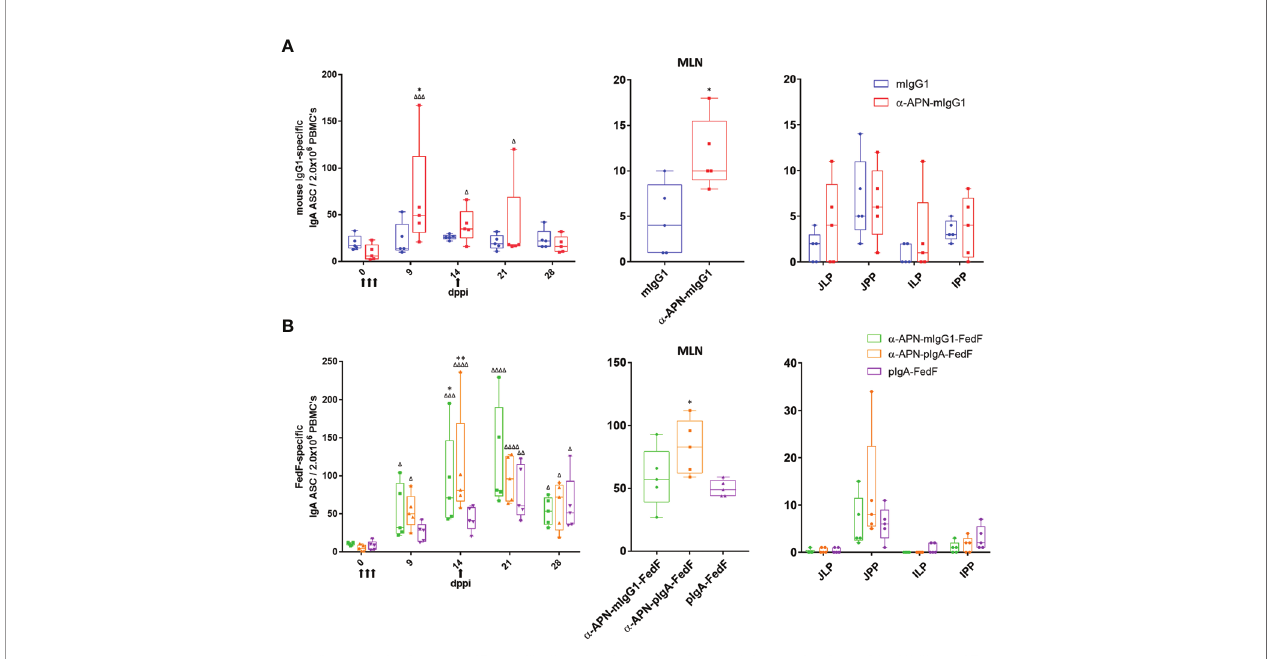
FIGURE 7 | Antigen-speci fi c antibody secreting cells after oral immunization with APN-speci fi c antibody constructs. ELISpot of (A) IgG1 -and (B) FedF-speci fi c IgA ASCs from PBMCs (left) isolated on 0, 9, 14, 21 and 28 dppi (days post primary immunization) and mononuclear cells isolated from mesenteric lymph nodes (middle) and intestinal tissues (right) 28 dppi. Arrows indicate days of immunization. Multiplicity adjusted p-values: * , D p < .05; ** , DD p < .01; DDD p < .001; DDDD p < .0001; * indicates signi fi cant differences compared to mIgG1 isotype or pIgA-FedF ctrl on same day, while D indicates signi fi cant differences for each group compared to day 0. n=5. mlgG1, mouse IgG1; plgA, pig IgA; MLN, mesenteric lymph nodes; JJLP, jejunal lamina propria; JJPP, Jejunal Peyer ’ s Patches; ILP, Ileal lamina propria; IPP, Ileal Peyer's